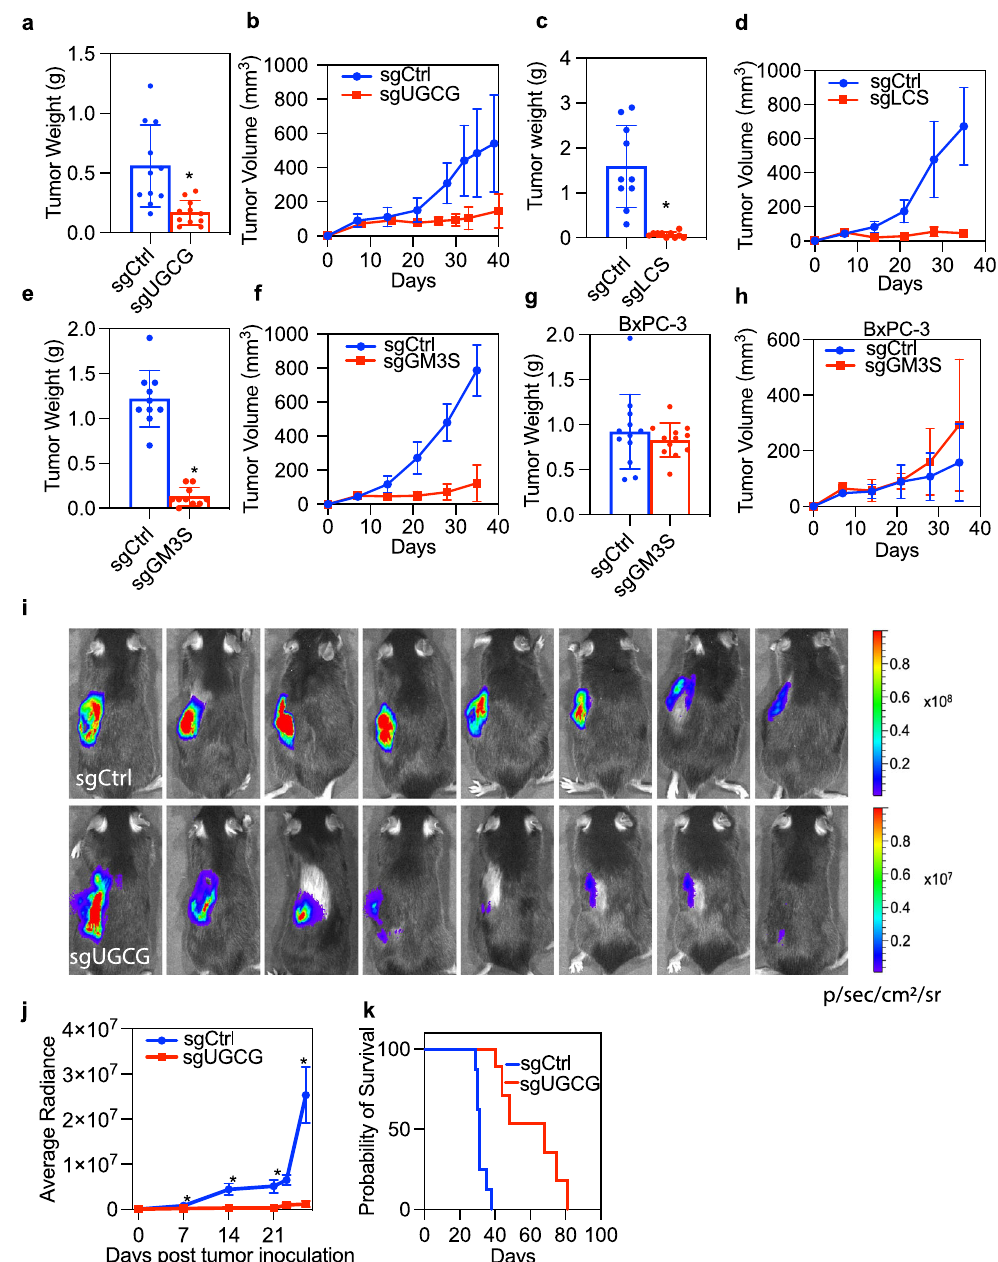
Fig. 6 | Targeting speci fi c GSL pathways suppresses PDAC tumors in